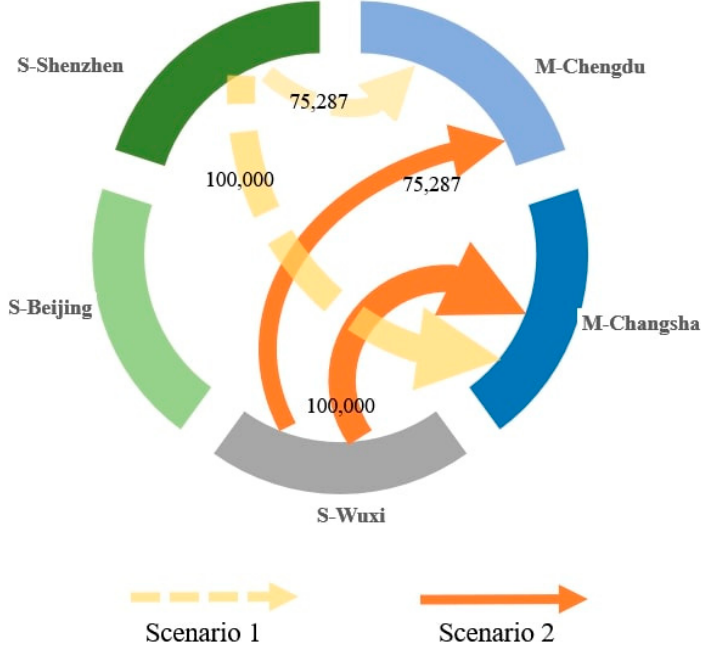
Figure 4. The solutions for Scenarios 1 and 2.